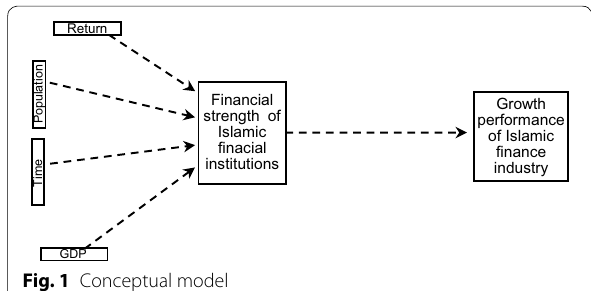
Fig. 1 Conceptual